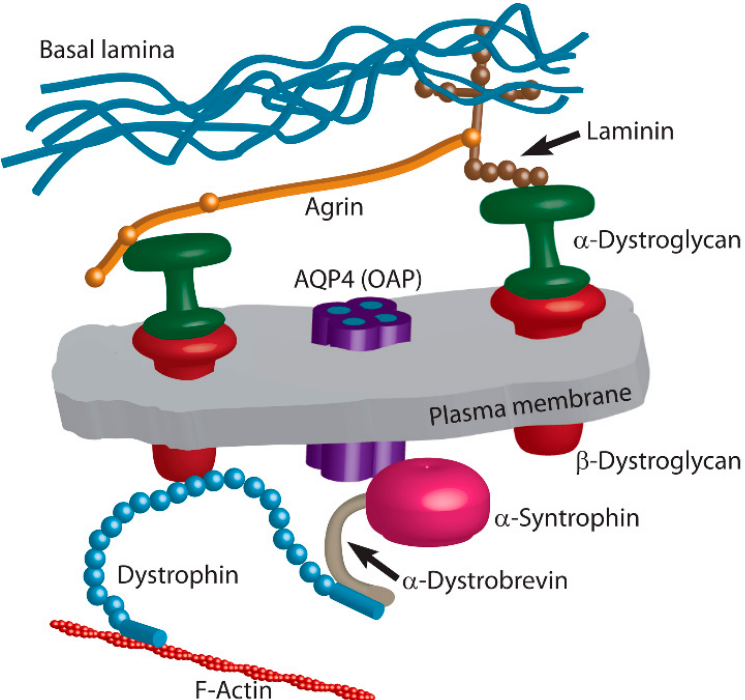
Figure 2. Positioning of individual AQP4 tetramers and OAPs in astrocytes is affected by intracellular and extracellular proteins. Agrin and laminin, components of the basal lamina, attach to α -dystroglycan, which forms a complex with β -dystroglycan that stretches through the plasma membrane. In the cytoplasm, it interacts with dystrophin, which binds to F-actin at one end and to α -dystrobrevin at the other end. α -Dystrobrevin interacts with α -syntrophin, which is directly linked to the AQP4 channel in the plasma membrane.